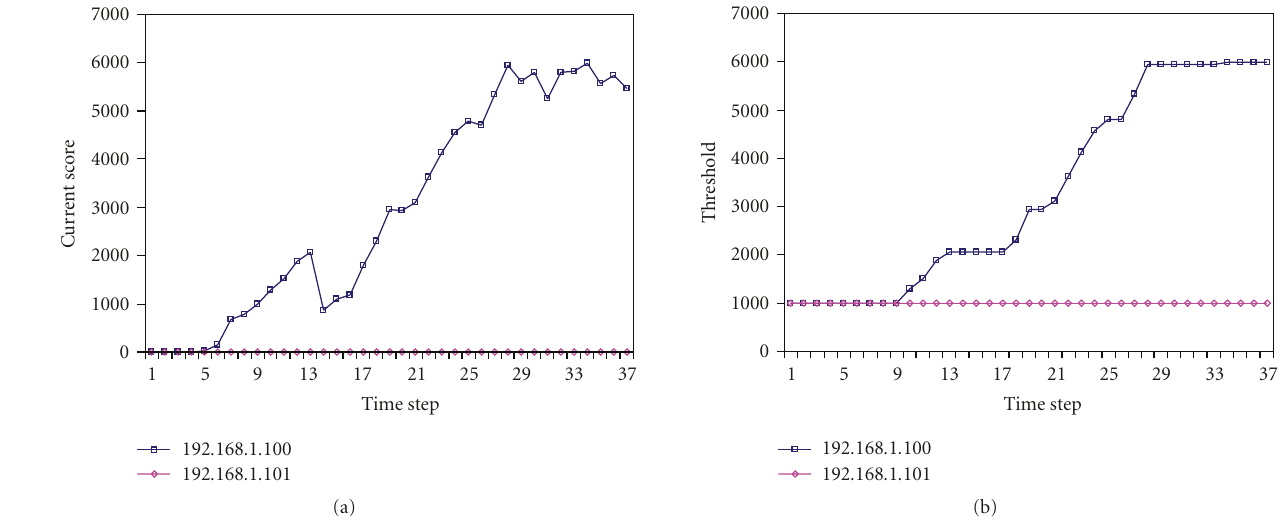
Figure 10: WOW tra ffi c analysis.